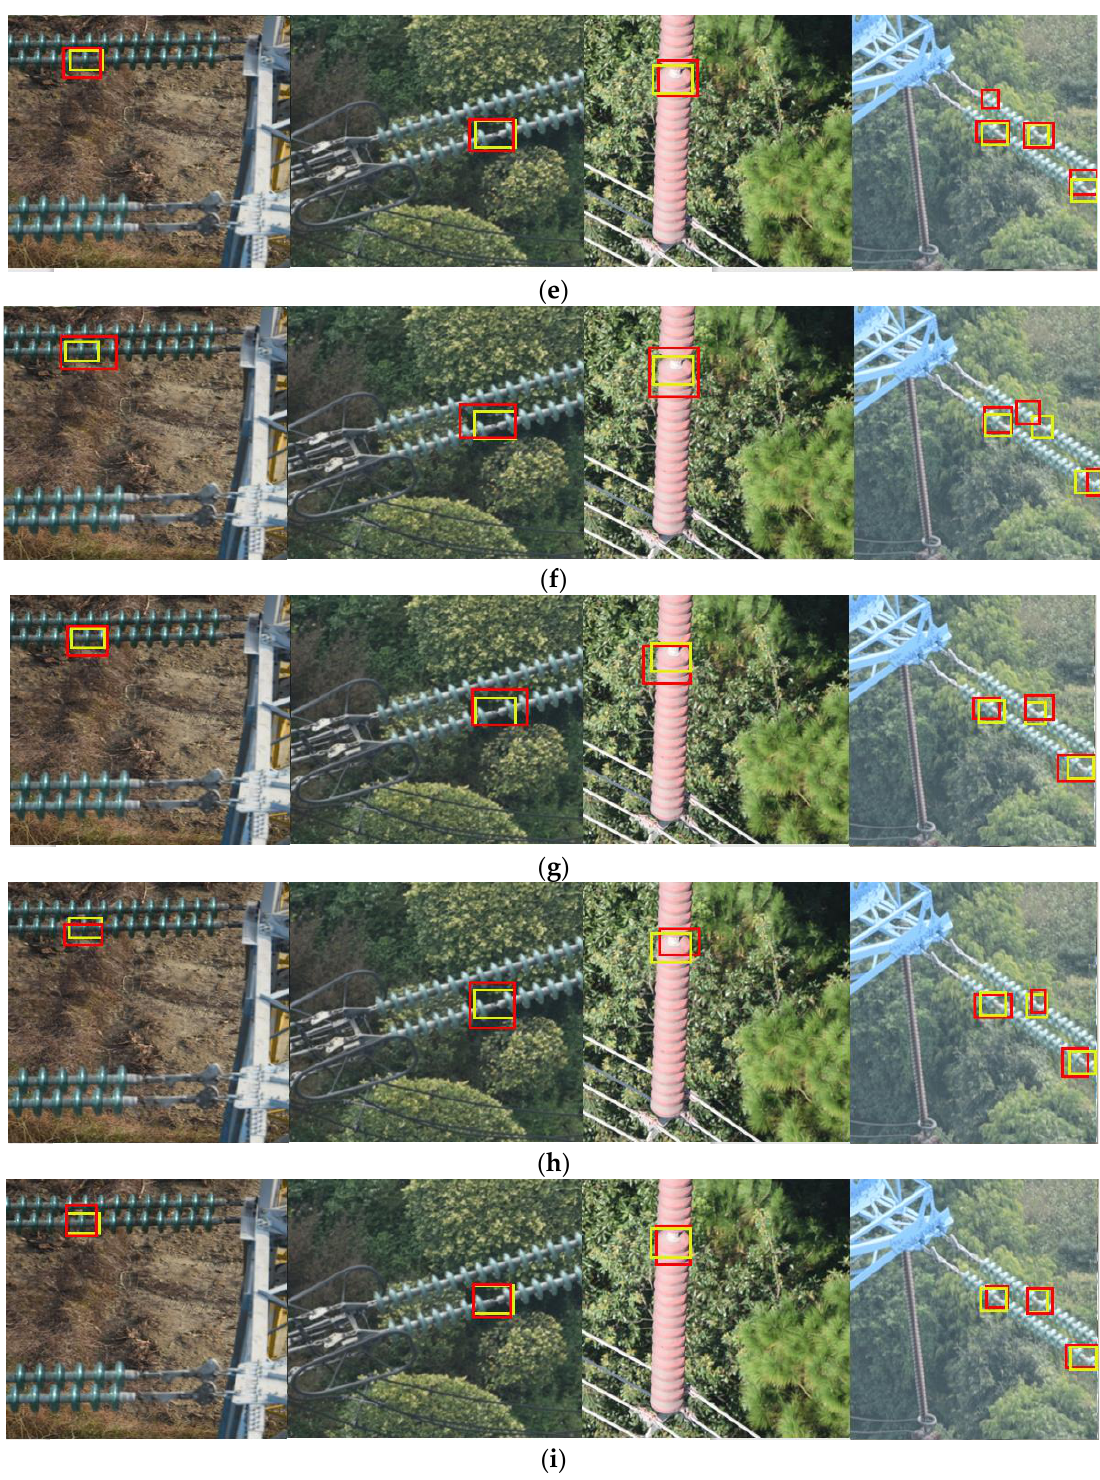
Figure 20. Qualitative results of all the examined methods. ( a ) HOG+SVM. ( b ) Haar+Adaboost. ( c ) YoloV3. ( d ) YoloV4. ( e ) Faster R-CNN. ( f ) ERCN-MobileNetV2. ( g ) ERCN-ResNet50. ( h ) CME-CNN-MoblieNetV2. ( i ) CME-CNN-ResNet50.